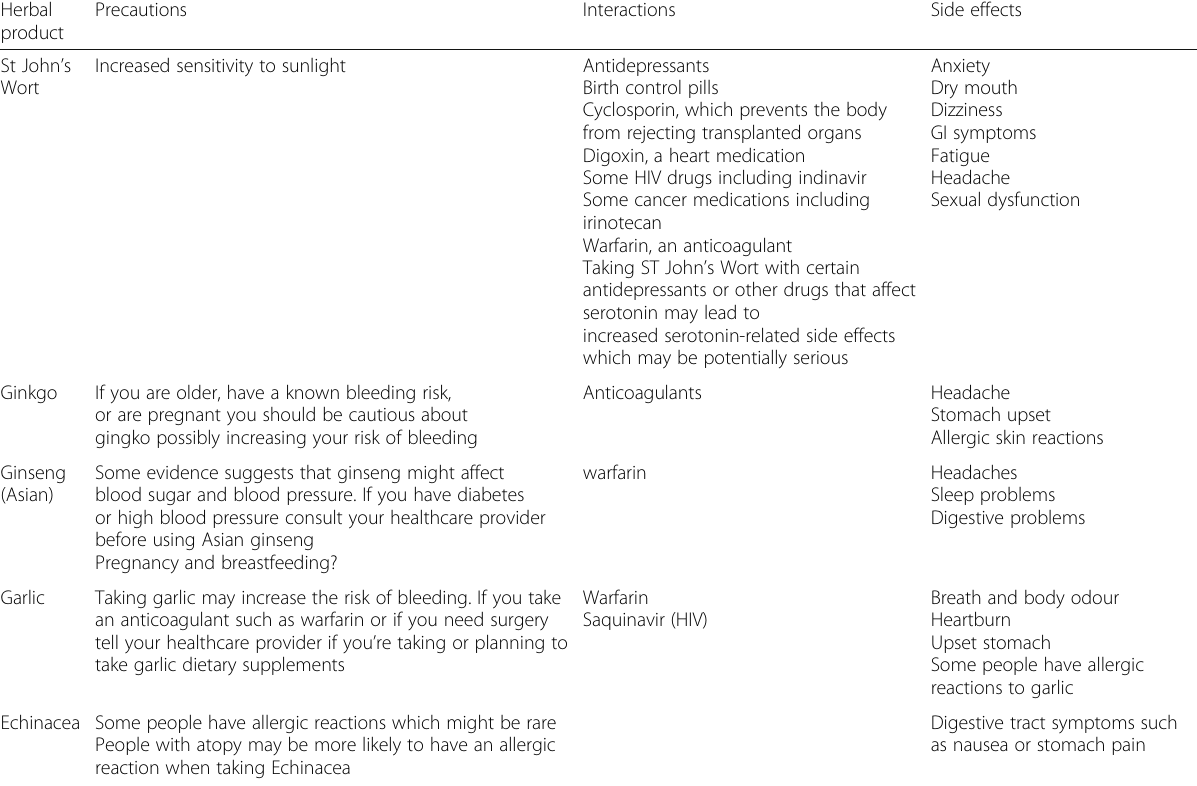
Table 1 Key safety criteria adapted from monographs developed by the National Center for Complementary and Integrative